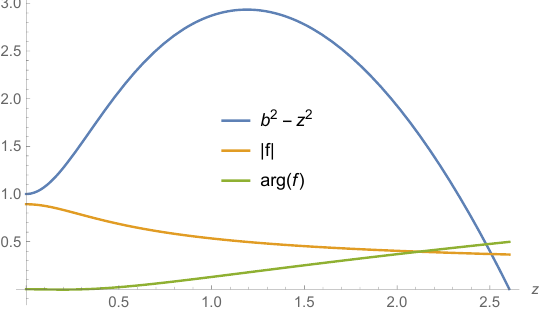
Figure 3 . Pro(cid:12)le of the single elliptic solution in four dimensions. We also plot the useful quan- tity b 2 ( z ) (cid:0) z 2 , which is the redshift factor g zz in the ( z; t ) coordinate chart and vanishes at the homothetic horizon.